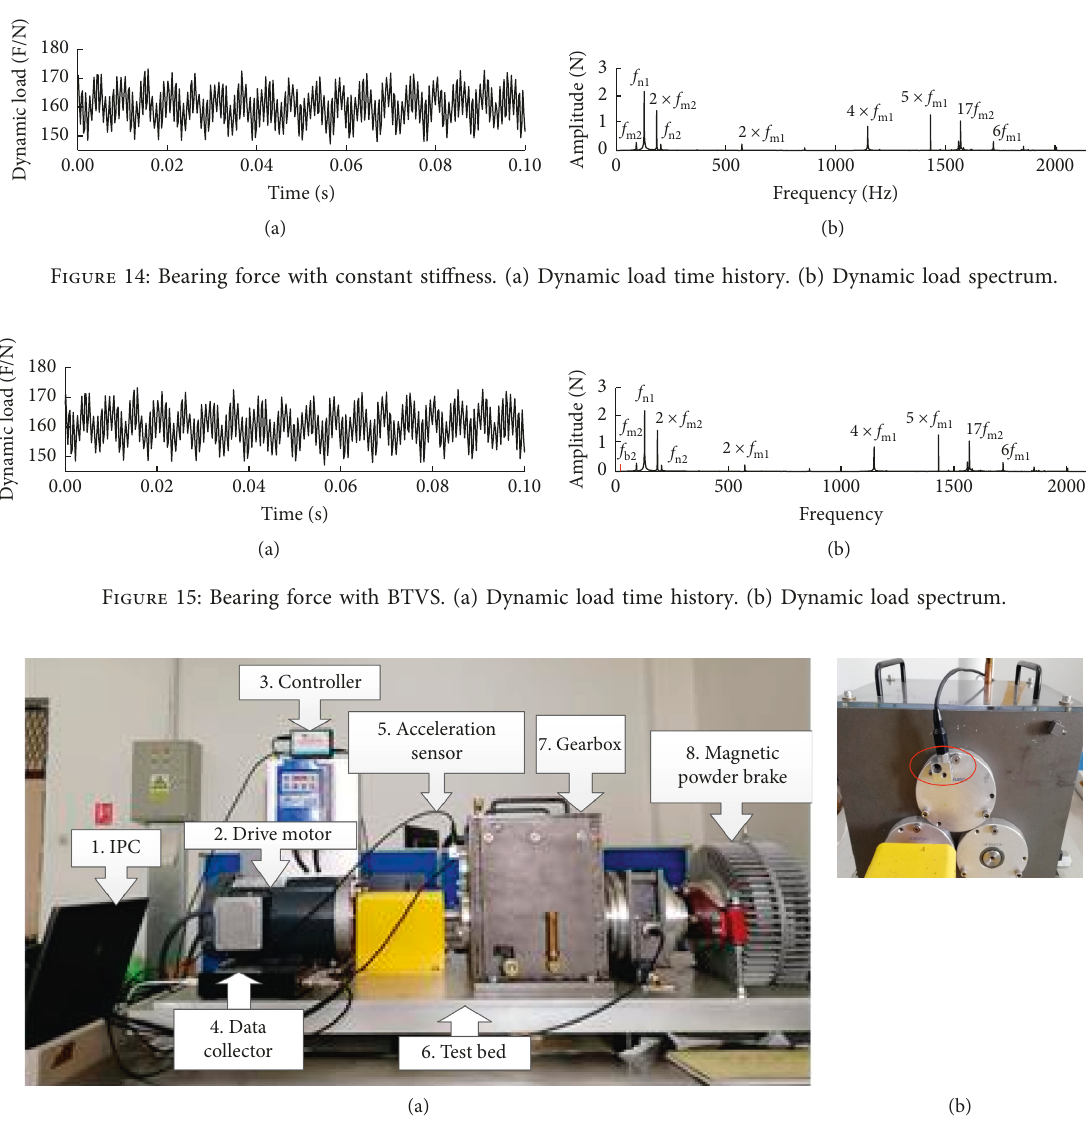
Figure 16: Test bench. (a) Transmission test-bed. (b) Measuring